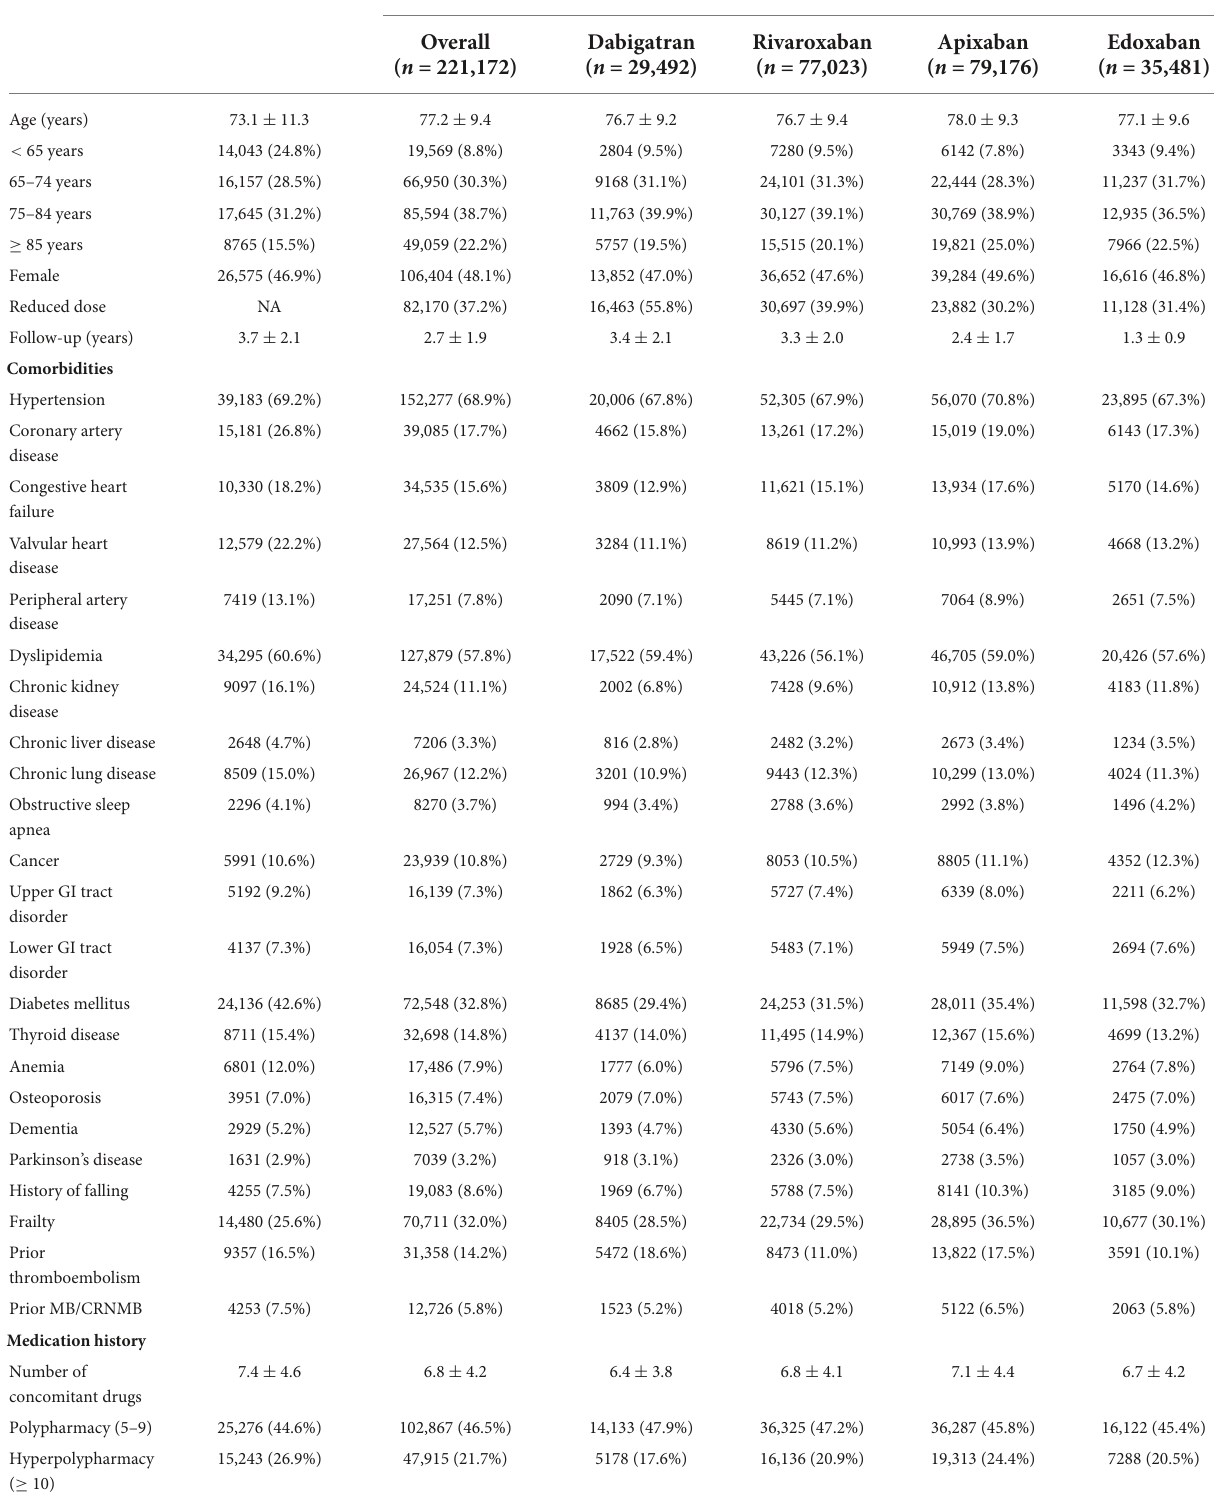
TABLE 1 Baseline characteristics of oral anticoagulant (OAC)-naïve non-valvular atrial fibrillation (AF) subjects with a CHA 2 DS 2 -VASc score of ≥ 1 in men or ≥ 2 in